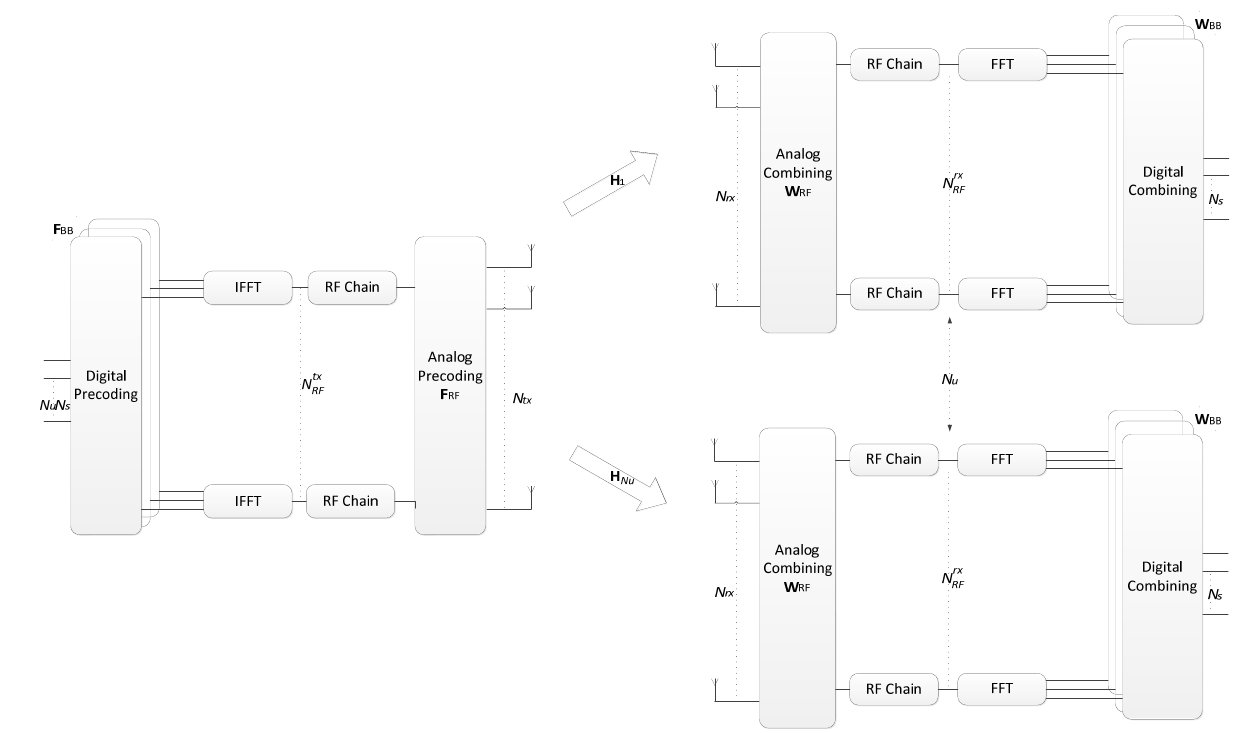
Figure 1. A multiuser OFDM mmWave/THz MIMO system with hybrid precoding.